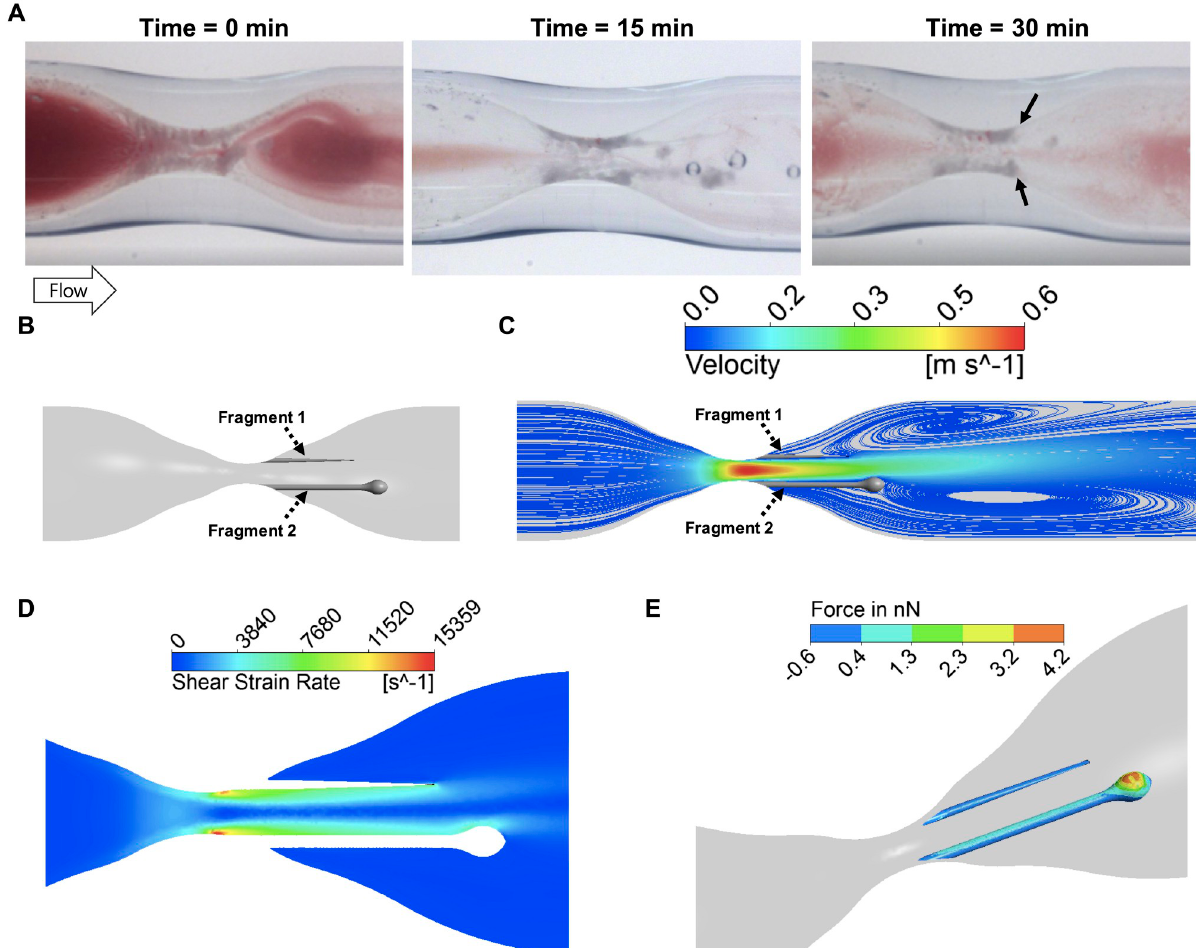
Fig 6. Simulation of flow and force through the stenosis using Computational Fluid Dynamics (CFD). A Structure of a thrombus during elongation and breakage at 0, 15, and 30 minutes of DiNAC perfusion. Black arrows denote points of tether breakage. B Computer model of the attached thrombus fragments at 15 min. C Velocity streamlines showing a jet-like flow and recirculation downstream of the elongated thrombus colored in gray. D Shear strain rate around the thrombus. A maximum shear of 15,000 s -1 (red) was observed in the throat of stenosis. E Drag force acting on the thrombi surface. The thrombus 2 fragment experiences a maximum force of > 4